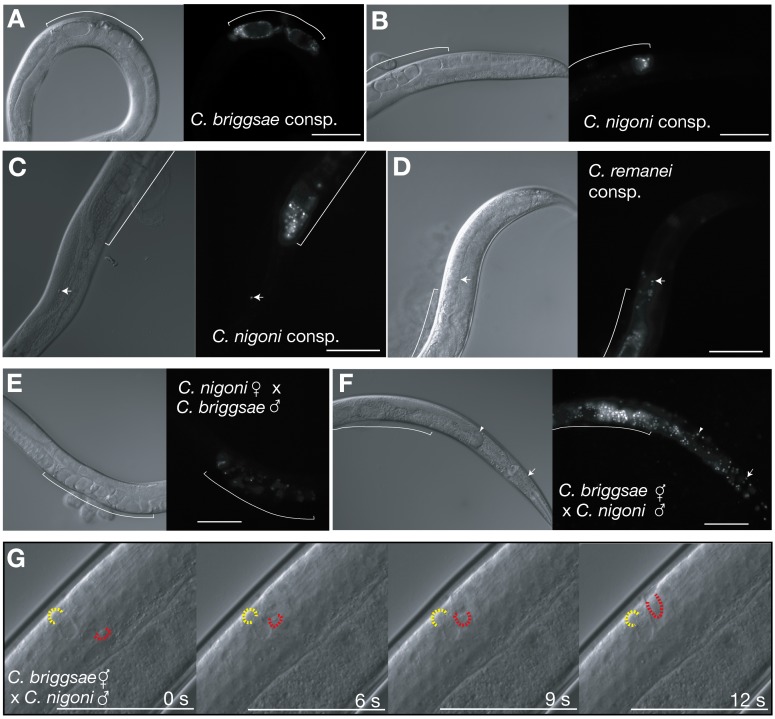
Heterospecific sperm invade maternal tissues.(A–F) Paired images of DIC and vitally dyed sperm inside maternal animals after conspecific and heterospecific crosses. (A) In conspecific crosses with C. briggsae, sperm remain completely in the uterus and spermatheca (bracket). (B) Female from C. nigoni conspecific cross displaying sperm localization to the uterus and spermatheca. (C and D) In rare cases of conspecific crosses for C. nigoni (C; 5%) and C. remanei (D; 8%), we observe isolated sperm (arrows) breach the distal spermathecal valve, but this does not cause sterility. (F) When C. nigoni males are mated with C. briggsae hermaphrodites, ectopic sperm are seen in large numbers, and in some cases breach the gonad completely. Wedge, anterior end of ovary; arrowhead, sperm nuclei in head region. (G) Series of frames from time-lapse movie (Movie S2) depicting movement of an individual ectopic C. nigoni sperm in the distal gonad of a C. briggsae hermaphrodite. The yellow crescent outlines the cell body of a sessile sperm, which serves as a reference point to highlight the motion of a second sperm, whose body is outlined in red.